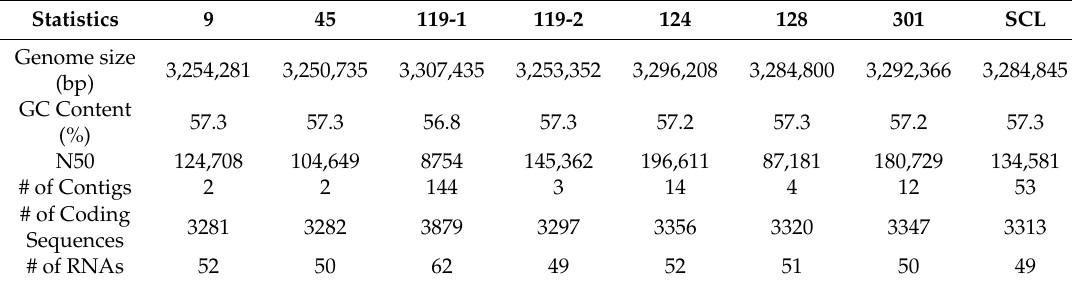
Table 2. Genome de novo assembly and annotation statistics of sequenced strains of B. canis using B. canis SCL strain as reference.